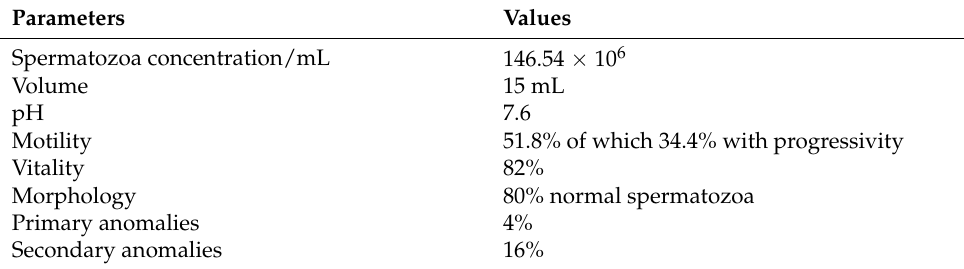
Table 2. Sperm parameters of the stallion used for in vivo study.